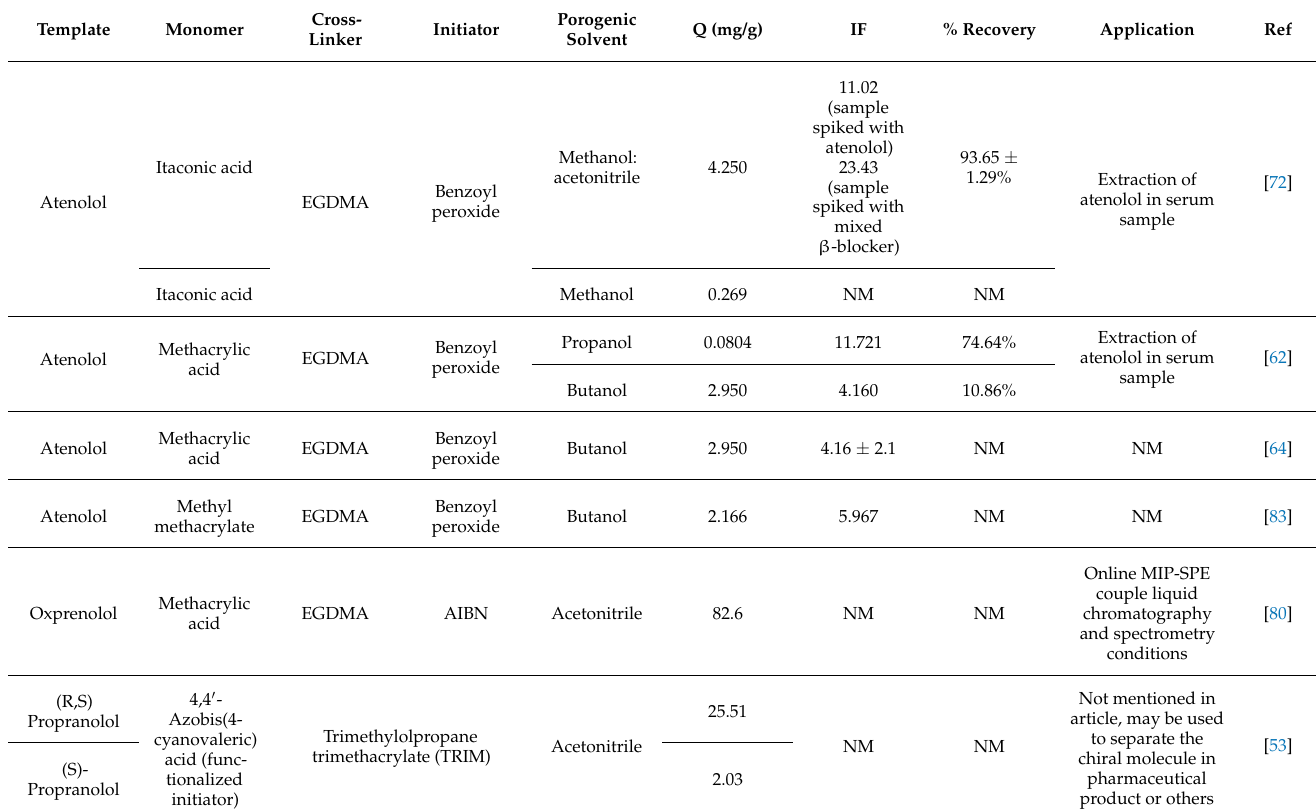
Table 5. Several studies on synthesis of MIPs using the precipitation polymerization